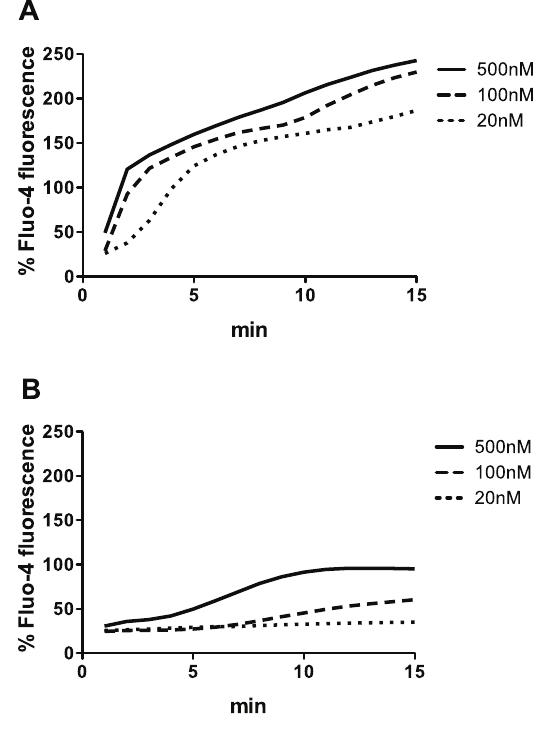
Figure 1. Calcium ion entry into human PMNs in presence of PVL (A) and LukGH (B) at the indicated concentrations. Leukotoxins were mixed with 2 6 10 6 /mL PMNs loaded with 4 m M Fluo-4 in presence of 1.1 mM CaCl 2 . Fluorescence intensity was recorded immediately and then every minute. Percent Fluo-4 fluores- cence was calculated according to the formula described in the methods section by using 1% Triton X-100 to estimate maximal fluorescence and 1 mM EGTA to determine minimal fluorescence. The results represent the mean of four independent experiments.